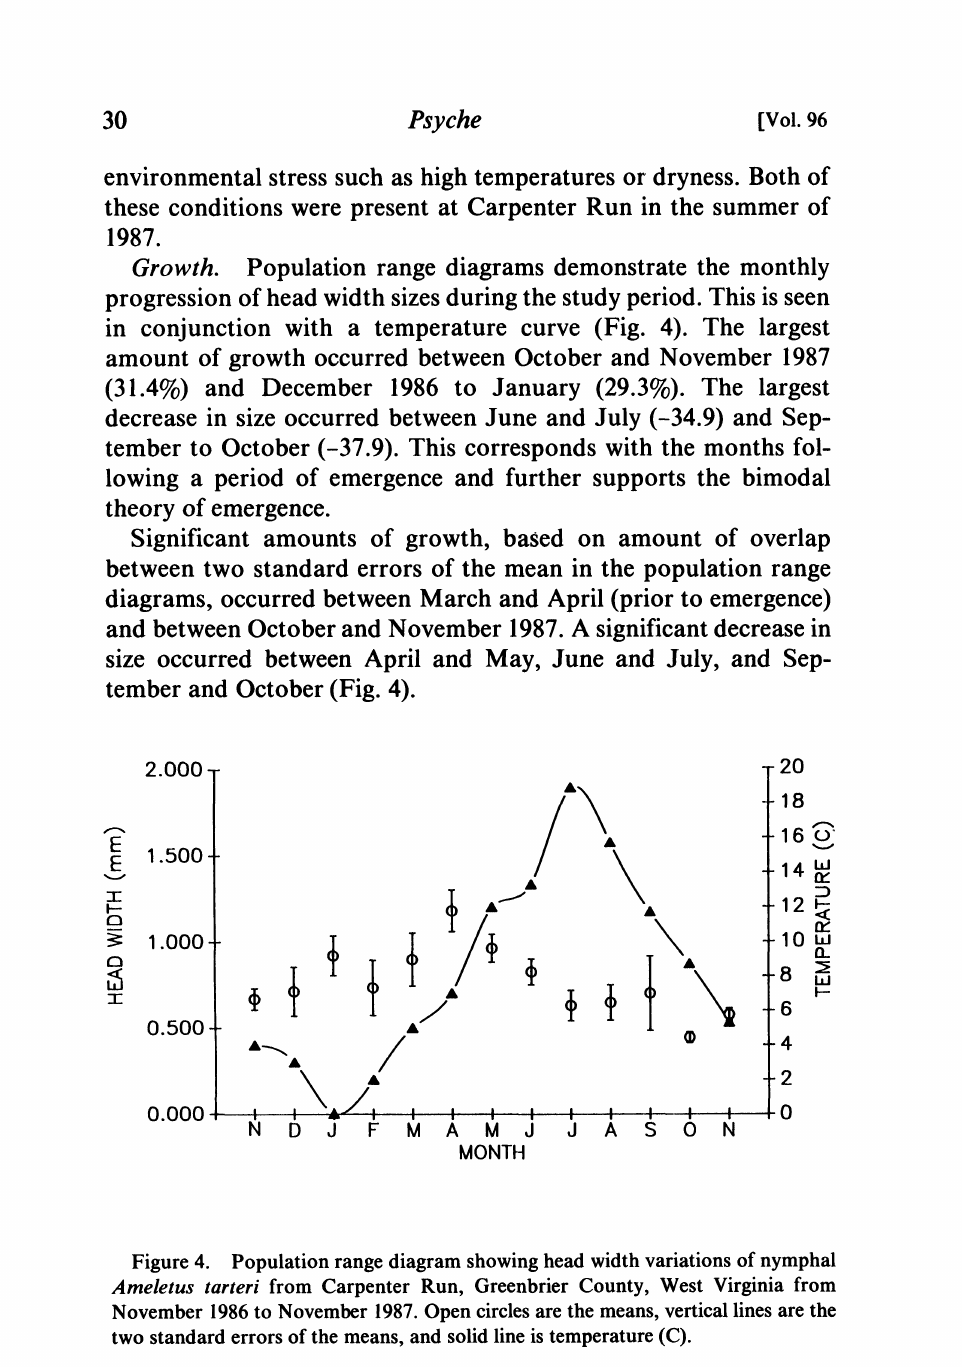
Figure 4. Population range diagram showing head width variations of nymphal Ameletus tarteri from Carpenter Run, Greenbrier County, West Virginia from November 1986 to November 1987. Open circles are the means, vertical lines are the two standard errors of the means, and solid line is temperature